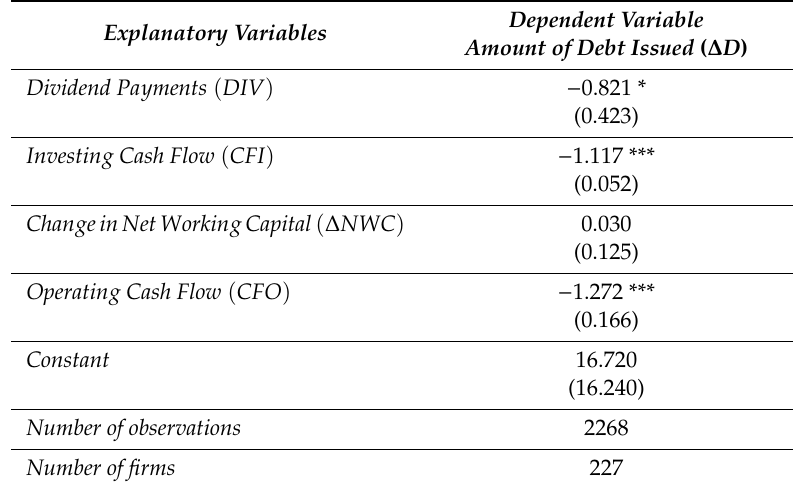
Table 4. Estimation results of the partially aggregated pecking order model.